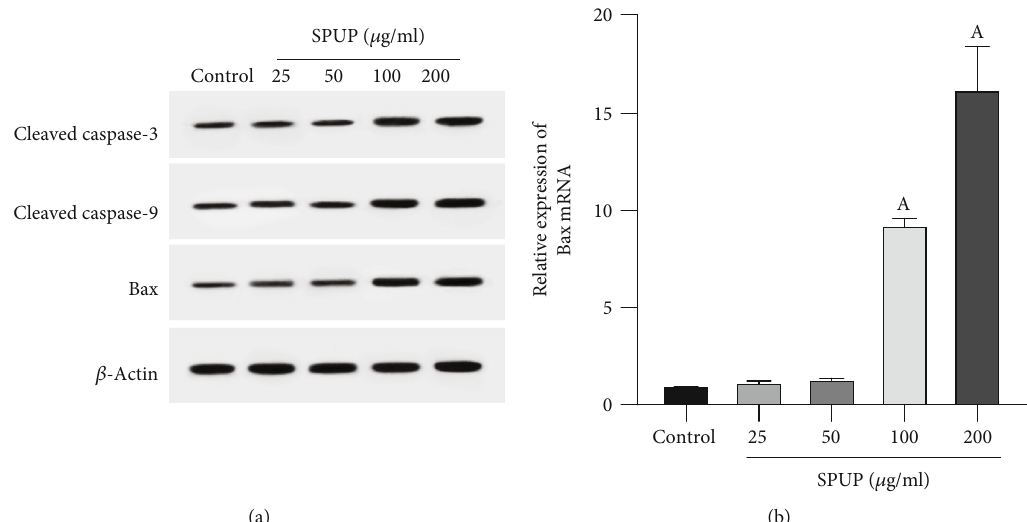
Figure 6: Expression of apoptosis-related protein and mRNA in DU145 cells treated with SPUP. Compared with the control group, A: <